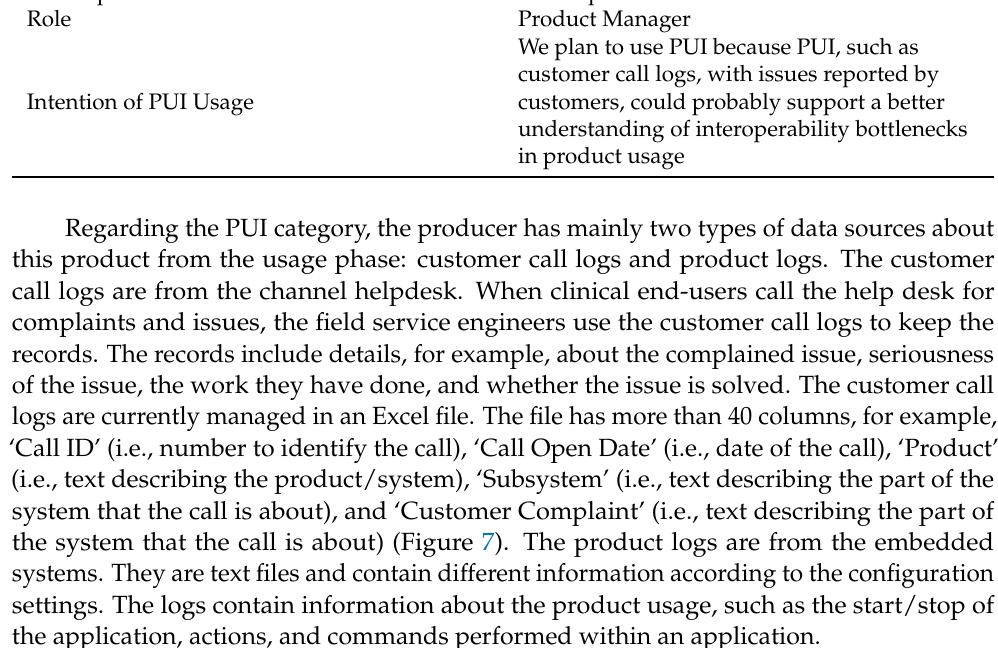
Table 3. Healthcare scenario: summary of the elements the activity category and personnel category. Elements Values